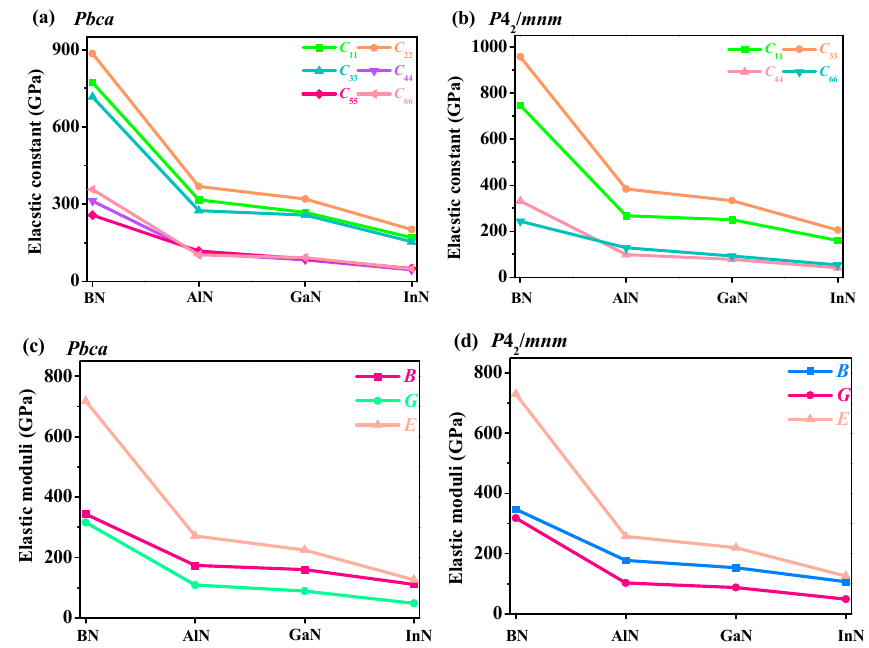
Figure 3. Elastic constants and elastic moduli of the Pbca XN ( a , c ) and P 4 2 / mnm XN ( b , d ).